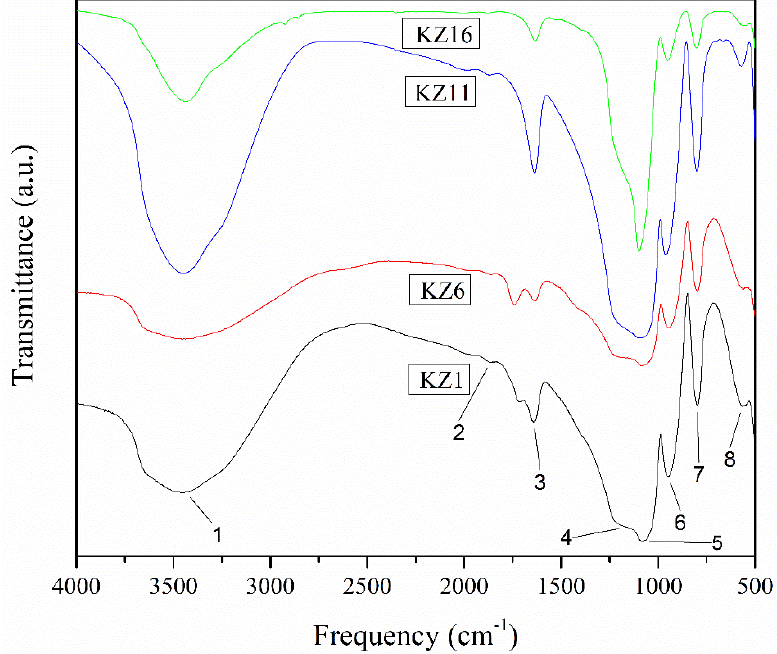
Figure 8. FT-IR spectrum of the pure silica obtained by synthesis with TEOS as a precursor and acetic